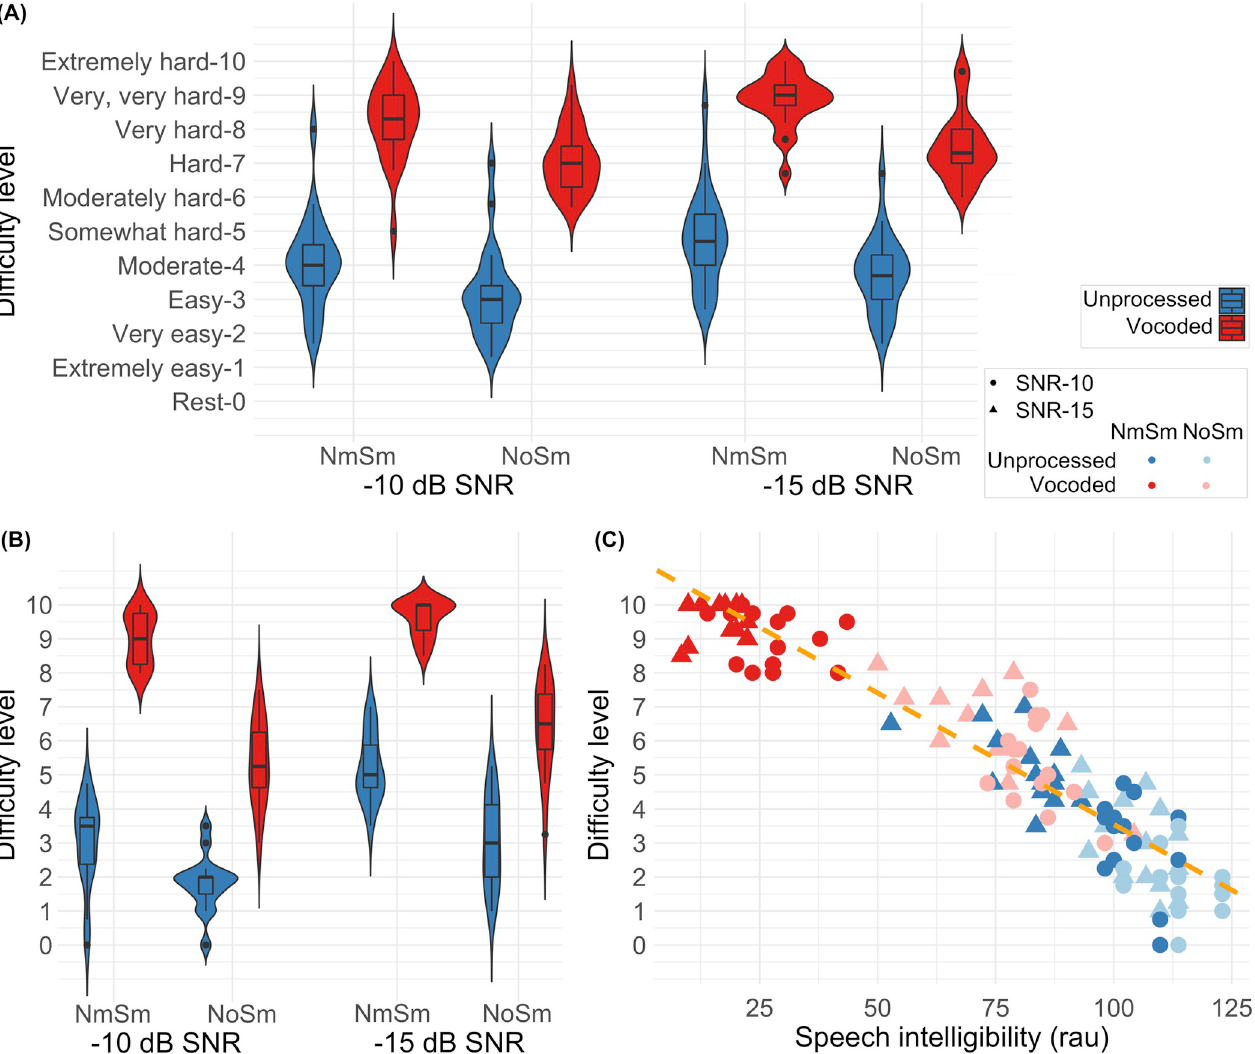
Fig 4. Subjects’ self-reported difficulty levels and speech intelligibility scores. Unprocessed (U, blue) or degraded (V, red) speech stimuli were always presented to the left ear alone. Noise stimuli were presented in ipsilateral (N m S m ) or bilateral (N o S m , squares) conditions. In panel (A), violin plots show self- reported difficulty levels in individuals under varying listening conditions at -10dB SNR (left) and -15 dB SNR (right) during fNIRS recording. Panel (B) shows the self-reported difficulty levels in a separate group of participants in a behavioral session with no fNIRS data being recorded. Panel (C) shows the correlation between the self-reported difficulty levels (vertical) and speech intelligibility in rationalized arcsine units (RAU, horizontal) in individuals in the behavioral session.